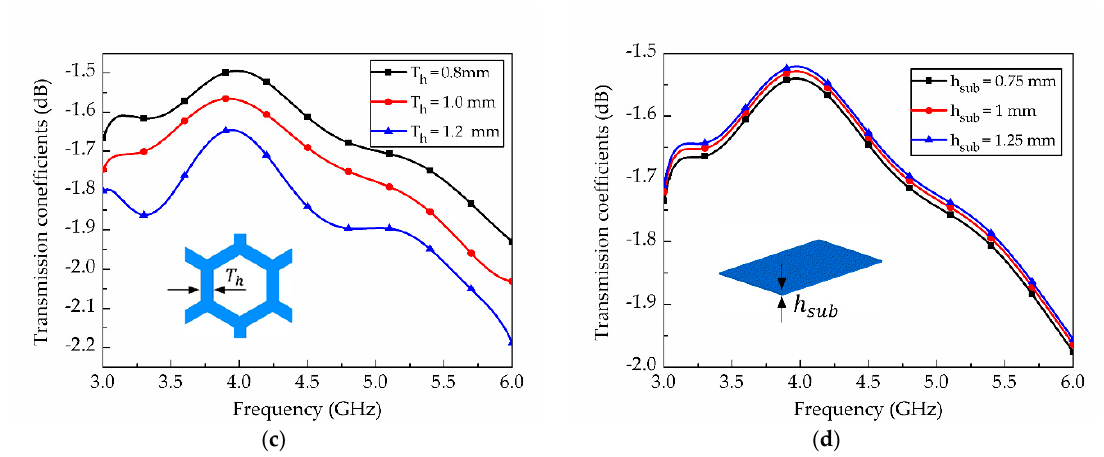
Figure 6. Simulated results of ( a ) SIW on honeycomb substrate; and transmission coefficients with respect to ( b ) L h ; ( c ) T h ; ( d ) h sub .